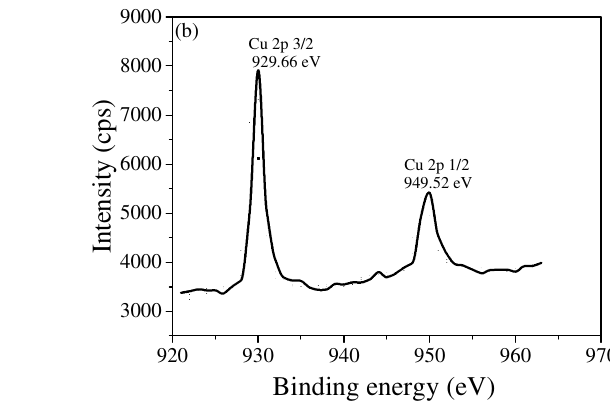
Figure 4. The ( a ) full range and ( b ) narrow range XPS spectrum of the Cu 2 O/Al 2 O 3 coating.